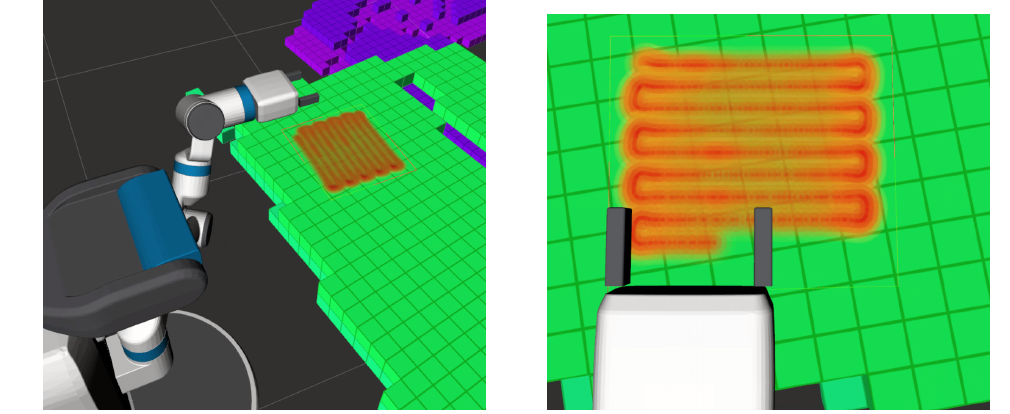
Figure 7. Two views of the heat map